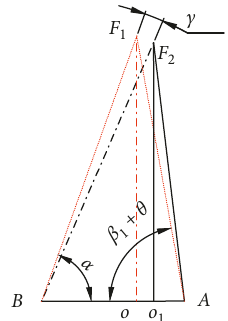
Figure 7: Movement triangle.